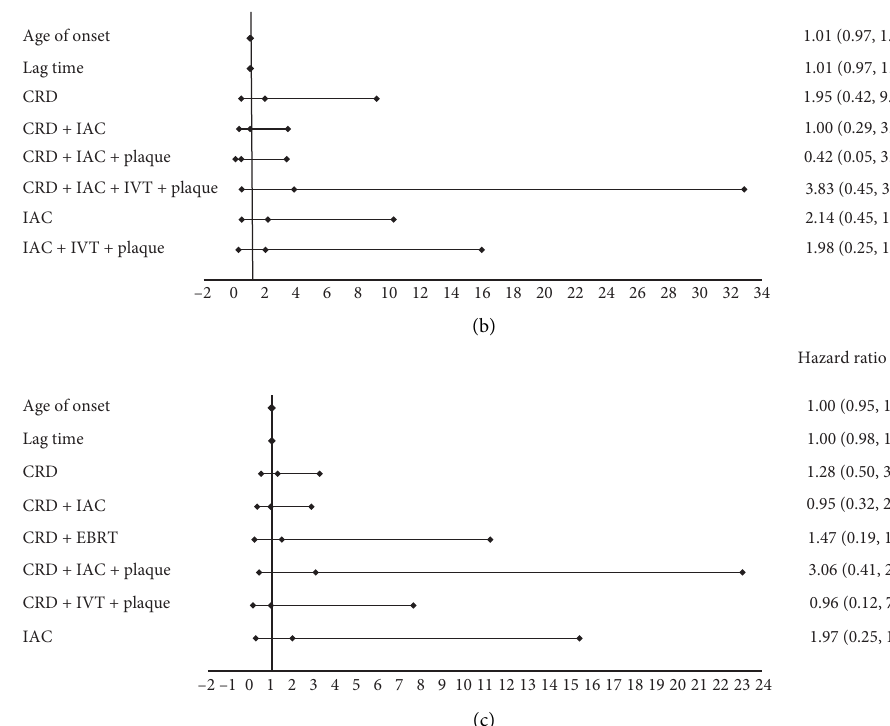
Figure 2: Hazard ratio of globe salvage according to patient characteristics and treatment modalities: (a) including all eyes (unilateral vs. bilateral); (b, c) unilateral and bilateral: based on the International Classification of Retinoblastoma (ICRB). CRD � chemoreduction; IAC � intra-arterial chemotherapy; EBRT � external beam radiation therapy; IVT � intravitreal